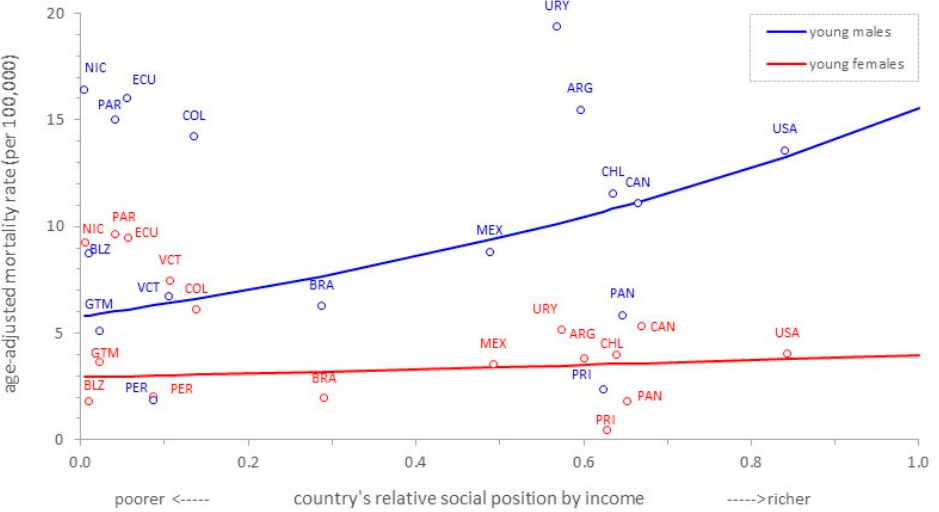
Figure 3. Cross-country income-related inequality gradients in mortality due to suicide in young (10–24 years old) males and females. Region of the Americas, 2015.